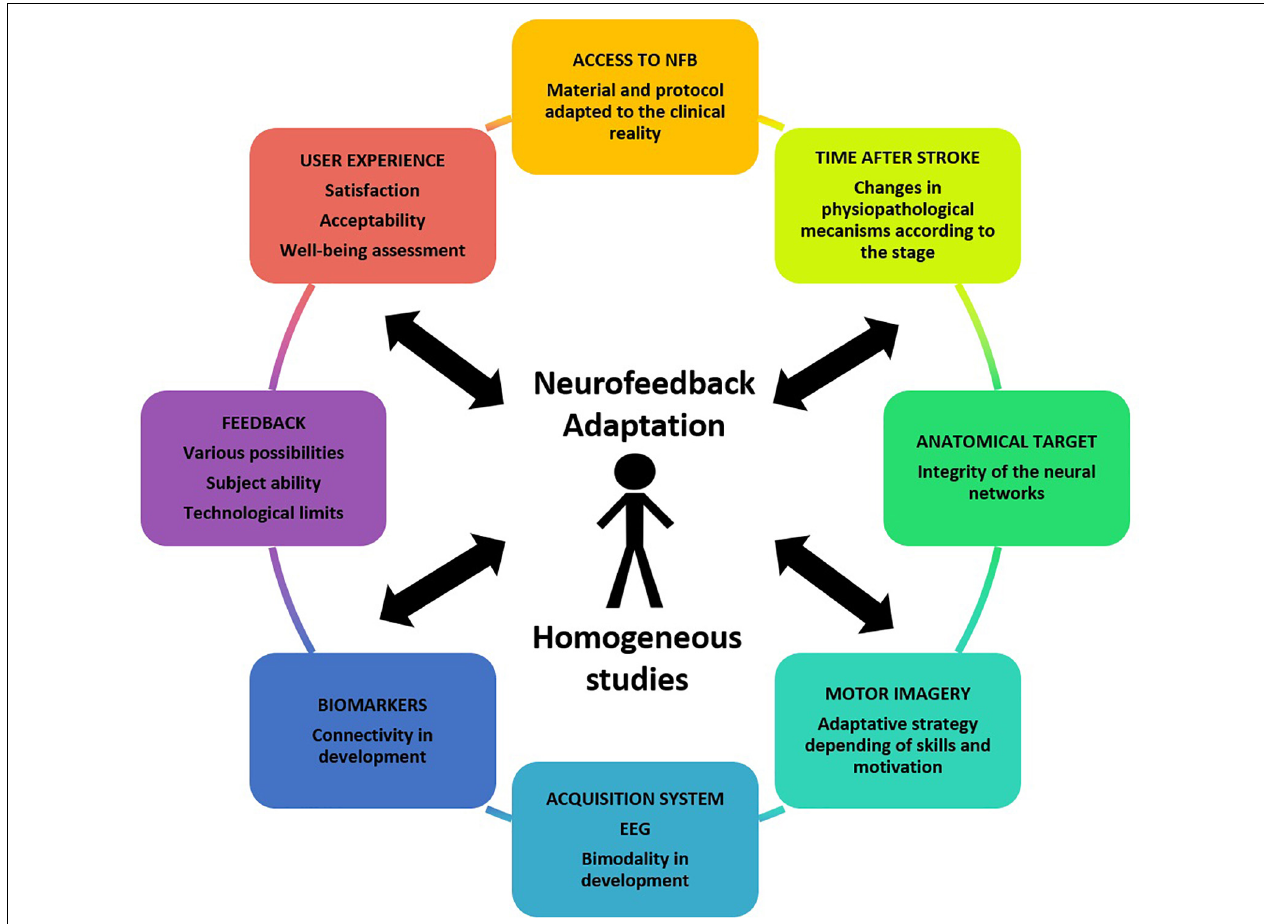
FIGURE 4 | Clinical, electrophysiological, pathophysiological, and material parameters to be taken into account in an NFB